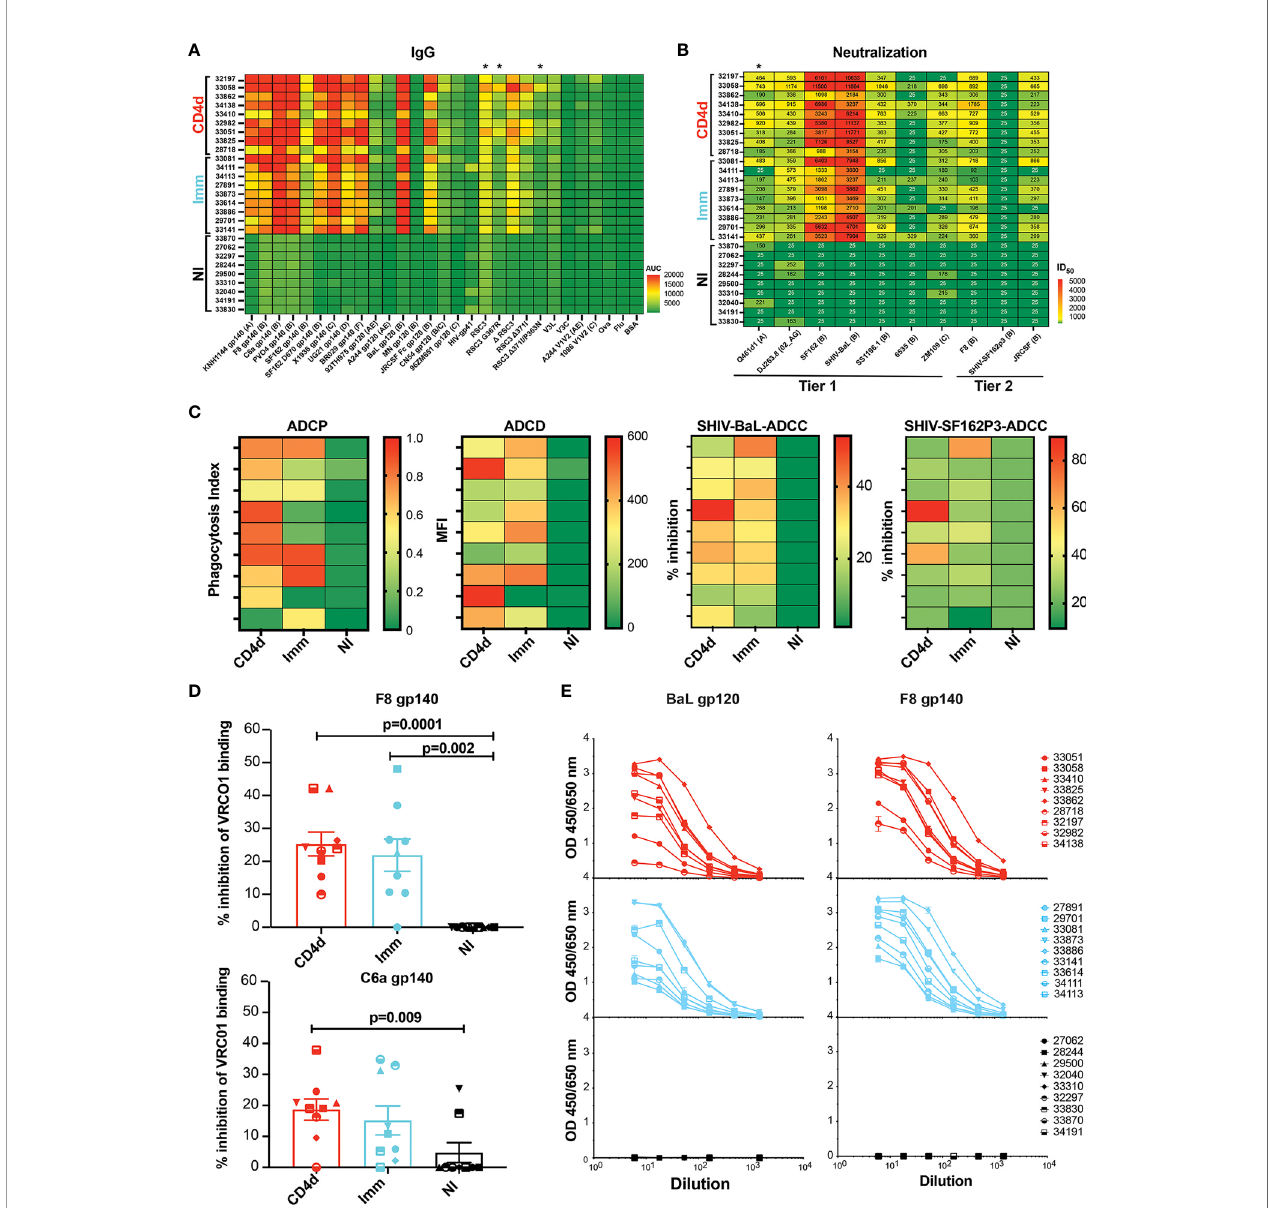
FIGURE 4 | Broad antibody response at week 34. (A) Overview of broad HIV-Envelope speci fi c IgG response at week 34. (B) Heterologous neutralizing antibodies elicited by VC10014 DNA plasmid and protein vaccine regimen. Rhesus plasma samples at week 34 were tested for neutralization in a TZM-bl assay. Neutralization data are expressed as ID 50 , the plasma dilution that neutralized 50% of the infecting virus. (C) Heat maps showing Ab-dependent cellular phagocytosis (ADCP, left panel), Ab-dependent complement deposition (ADCD, middle panel) and Ab-dependent cellular cytotoxicity (ADCC, right two panels) between CD4d, Imm, and NI groups. (D) Competition ELISA showing the inhibition of CD4bs-speci fi c VRC01 mAb to HIV envelope in rhesus plasma. (E) ELISA showing autologous F8 gp140 speci fi c IgG and heterologous Bal gp120 speci fi c IgG in buccal mucosa of CD4d, Imm, and NI rhesus macaques. Red = CD4 depleted (CD4d) group, turquoise = Immunized (Imm) group, black = Non-Immunized (NI) group. * indicates signi fi cance (p < 0.05) as determined by unpaired t-test comparing Imm and CD4d